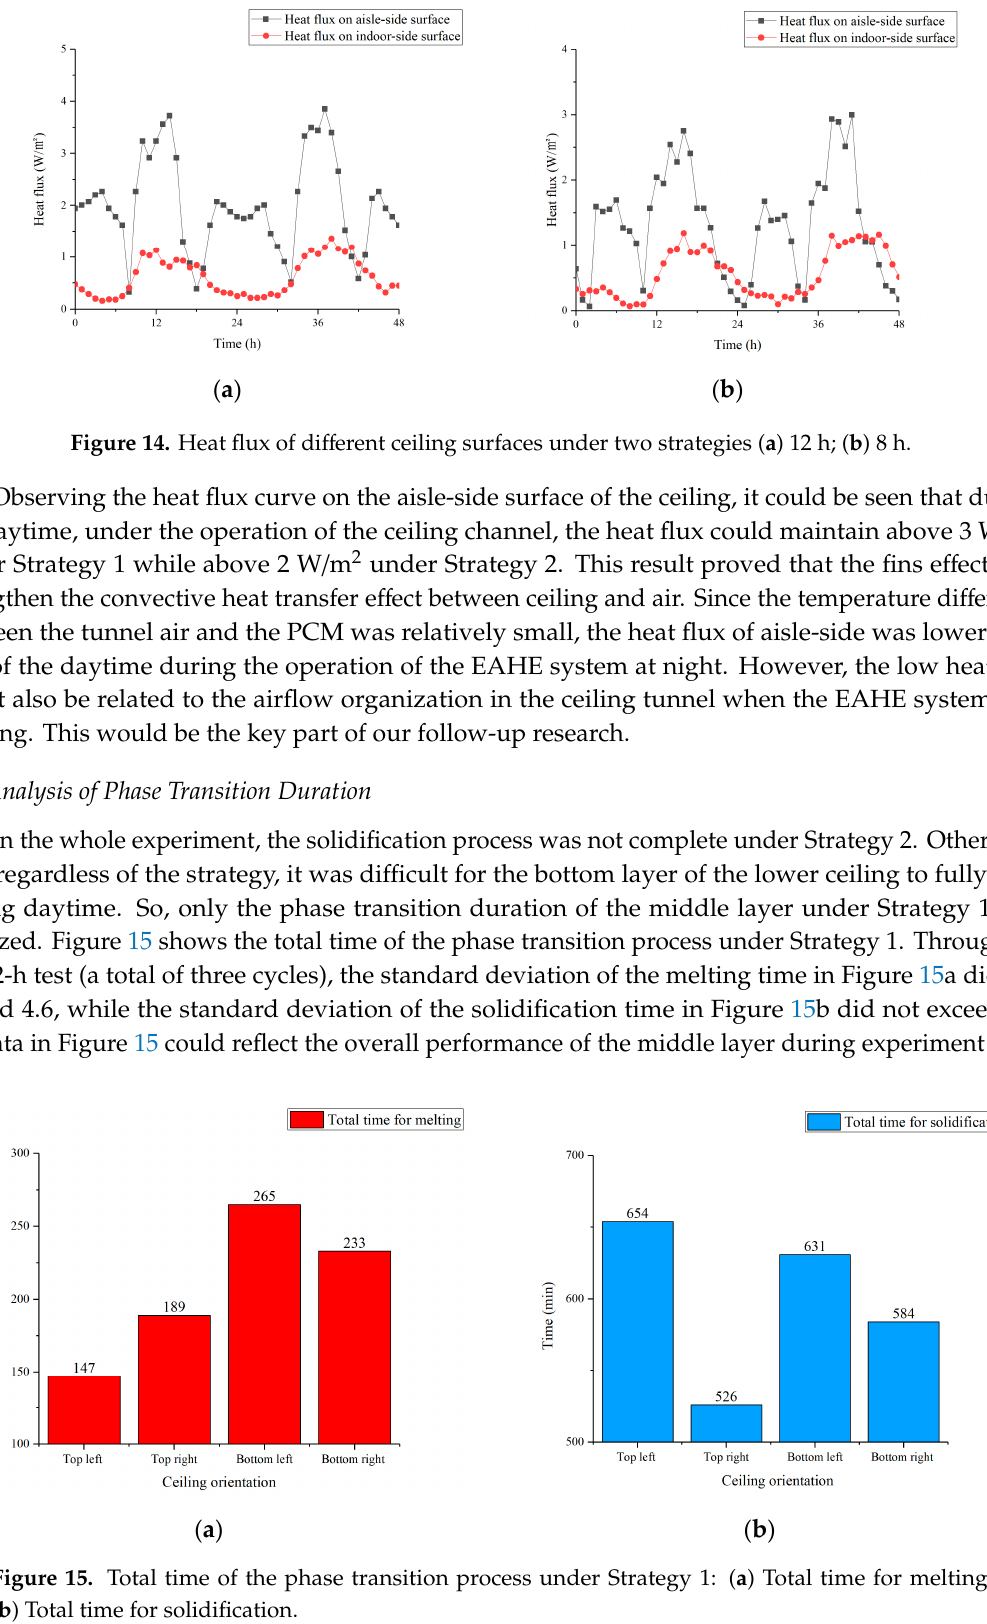
( b ) Figure 13. Horizontal contrast of ceiling temperature under two strategies ( a ) 12 h; ( b ) 8 h. 3.5. Comparison of Heat Flux on Different Ceiling Surfaces Figure 14 shows the heat flux on the indoor-side surface of the ceiling and aisle-side surface under two strategies. To focus on the performance of convective heat transfer between ceiling and